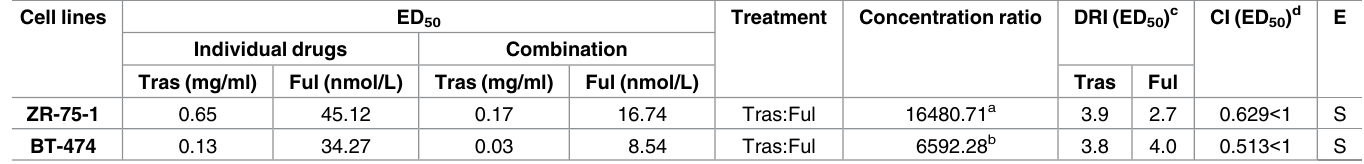
DRI values indicate that the doses of trastuzumab and fulvestrant required in the combination treatment groups are much lower than those used in the individually treated groups in both cell lines. Despite the use of lower concentrations in the combination treatment group, equal effects were observed over the same period as in individually treated groups. Thus, both drugs exhibited synergistic effects when used in combination as CI < 1 for both drug combinations and cell lines. a Tras:Ful concentration ratio = 0.1(g/L)/(606.77 × 10 × 10 − 9 )(g/L) = 16480.71. b Tras:Ful concectration ratio = 0.02(g/L)/(606.77 × 5 × 10 − 9 )(g/L) = 6592.28. (606.77: MW of fulvestrant. c DRI value at the ED 50 level. d